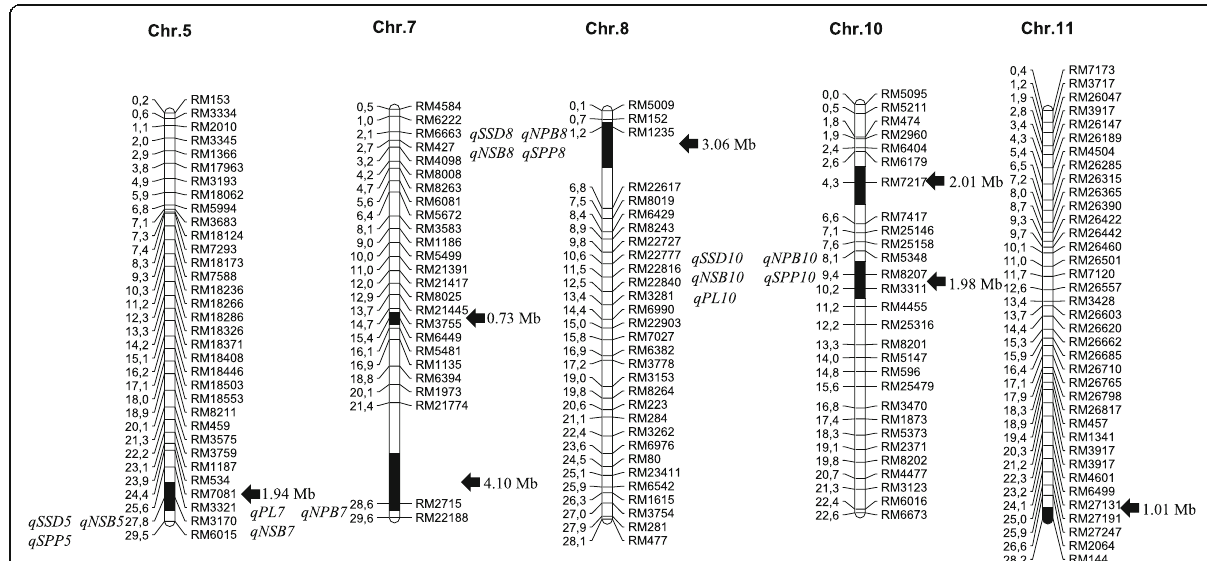
Fig. 1 Substitution segments and detected QTLs in Z749. Physical distances (Mb) and mapped QTLs are marked at the left of each chromosome; markers and substitution length (black arrow direction) are displayed to the right of each chromosome. PL: panicle length, NPB: number of primary